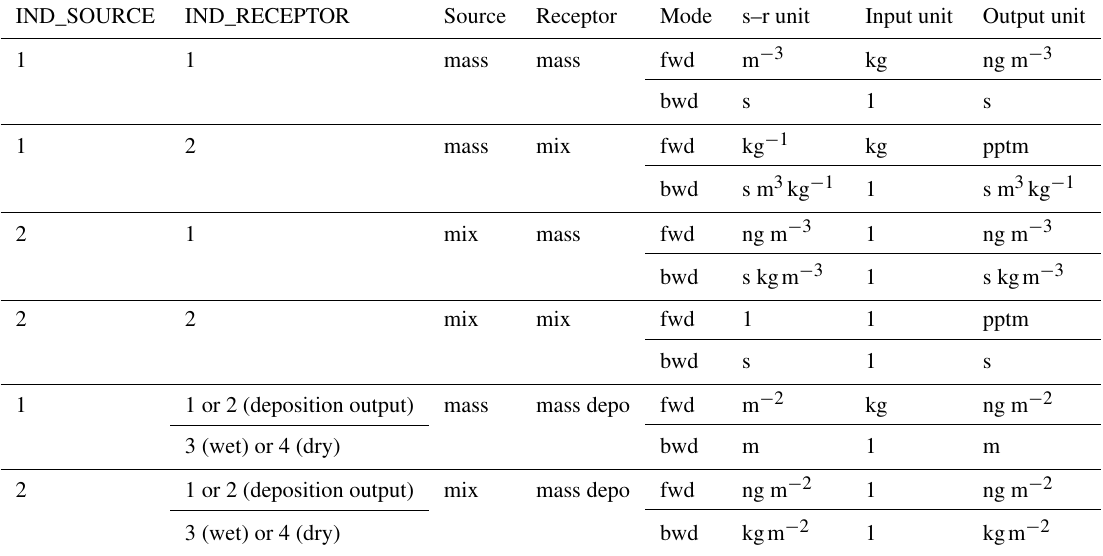
Table 1. Extension of Table 2 from Stohl et al. (2005) to deposition quantities. The table reports the input and output units used for FLEX- PART forward and backward simulations. IND_SOURCE and IND_RECEPTOR are the values chosen in FLEXPART’s “COMMAND” file to produce the corresponding simulation. Notice that in backward simulations the release takes place at the receptor and the sampling at the source. In forward mode, the deposition output is always provided in mass units and no specific user setting is needed, as the deposition output is made in addition to the concentration (or mixing ratio) output. See further explanations in the main text. In the columns s–r unit and Input unit, the number 1 means dimensionless.